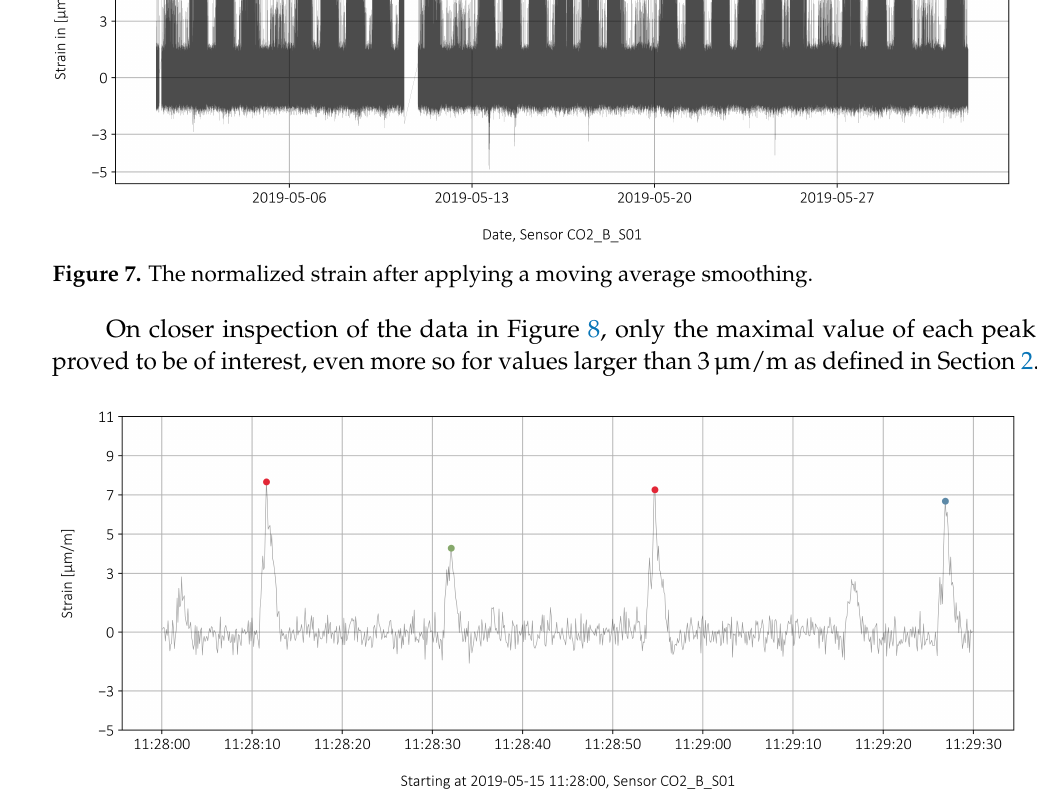
Figure 8. Categorized peaks over an interval of 90 s or 900 data points.